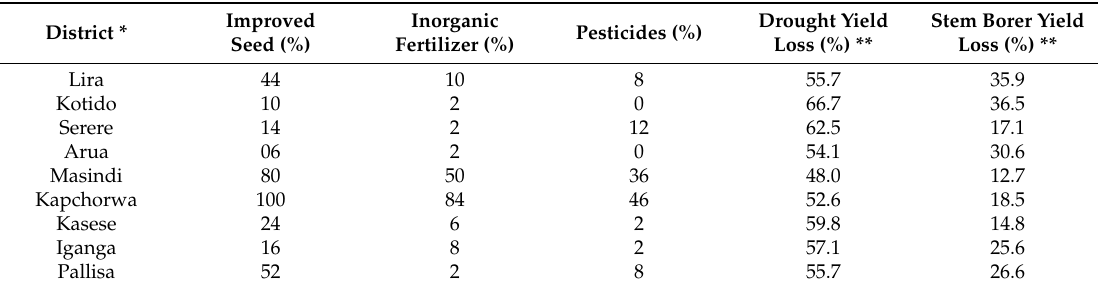
Table 2. Details on average input use of farmers and the importance of grain yield losses from drought and stem borer in the nine survey districts of